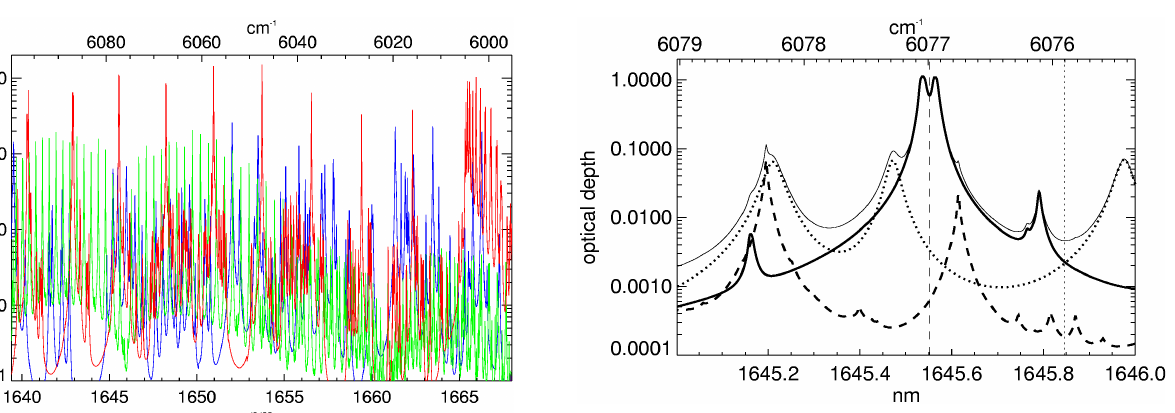
Fig. 2. Optical depth of the vertical total atmospheric column of water vapour (blue), carbon dioxide (green) and methane (red) ab- sorption lines under standard atmospheric conditions, as function of wavelength and wavenumber (top axis), from HITRAN 2008 data.